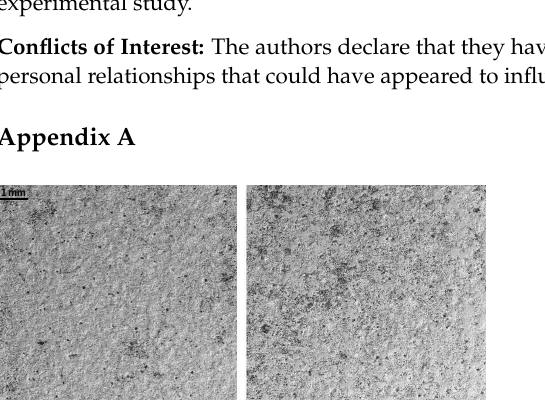
Figure A1. SEM image of stainless steel surface for non-ESD ( left ) and ESD ( right ) scaled to 1 mm.